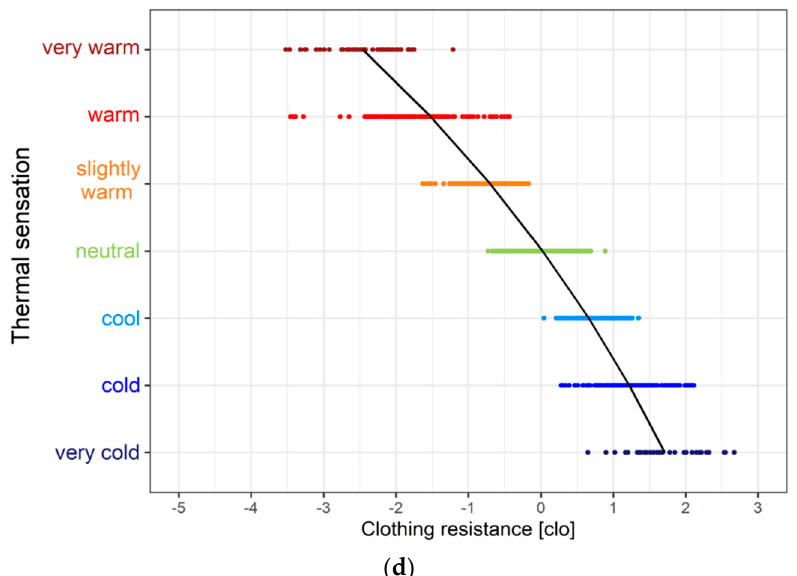
Figure 3. ( a ) The r cl – T o –thermal sensation relationships for persons 4 and 5; ( b ) The thermal sensation-r cl relationships for persons 4 and 5; ( c ) The r cl – T o –thermal sensation relationships for all Hungarian persons; ( d ) Dependence between thermal sensation and r cl for all persons considered.